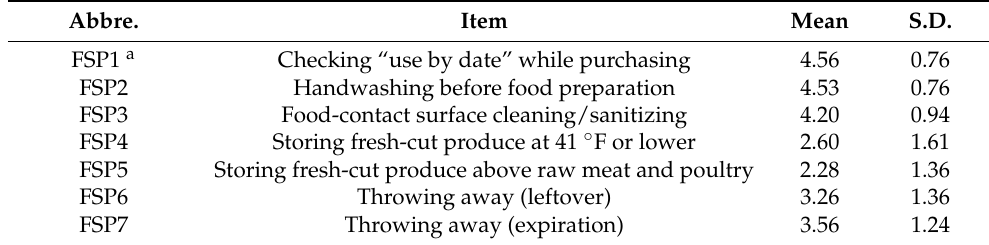
Table 3. Descriptive analysis of food safety practices associated with fresh-cut produce. Abbre.